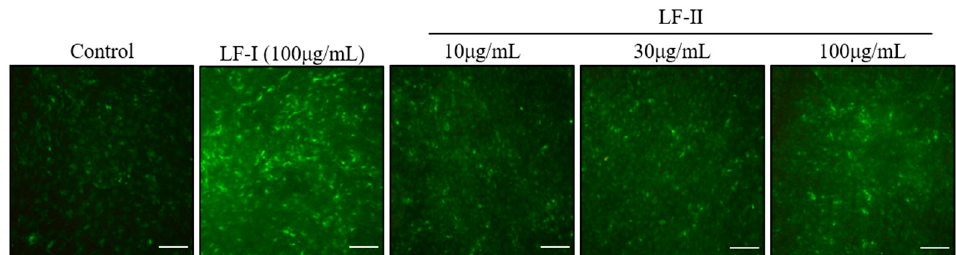
Figure 5. Results of immunocytochemistry after LF-I or LF-II treatment with ascorbic acid (50 μ g/mL) and β -GP (10 mM) for 2 weeks. Green-fluorescence intensity shows OPN expression levels. Bar = 200 μ m.